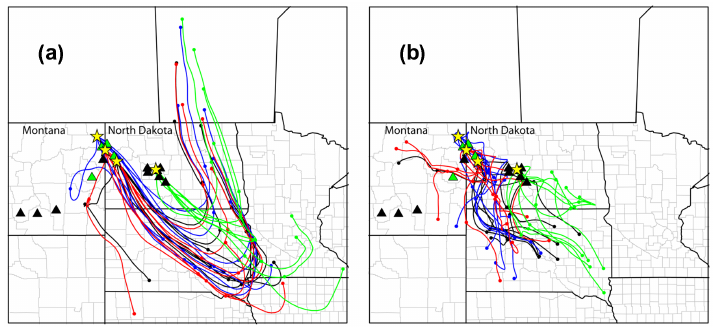
Figure 6. 48h back trajectories from THRO-N (black), MELA (blue), FOUS (red) and KNRI (green) for (a) 20–22 February, 8a.m. to 8a.m.; and (b) 27–29 March, 8a.m. to 8a.m. Back trajectories were run four times per day. Each dot designates a 24h period. Field sites are shown as gold stars. Power plants are shown as triangles, with black triangles representing coal-powered plants, and green triangles representing gas-powered